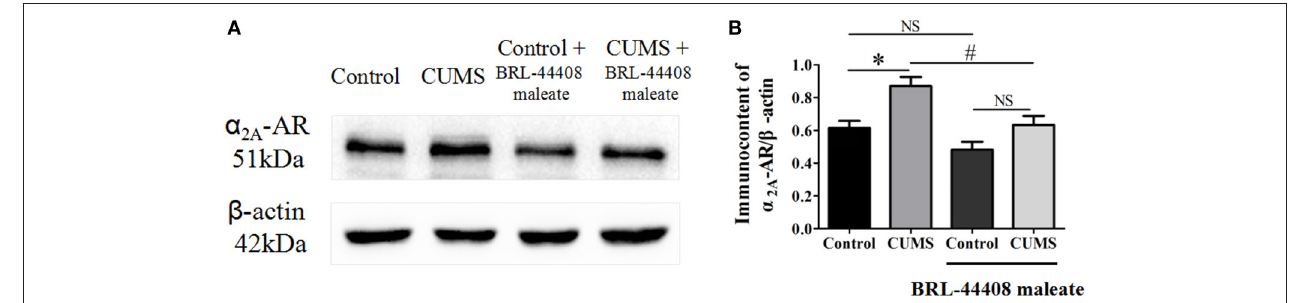
FIGURE 4 | Intraperitoneal injection of BRL-44408 maleate can reverse the increase of α 2A -AR induced by CUMS in the hypothalamus of the CUMS rats. (A.B ) The protein expression levels of α 2A -AR was significantly increased in the hypothalamus of the CUMS rats, peripheral administration of BRL-44408 maleate significantly decreased the expression levels of α 2A -AR in the CUMS rats. * p < 0.05 vs. the control rats. # p < 0.05 vs. before BRL-44408 maleate in the CUMS group. NS represents no significance.